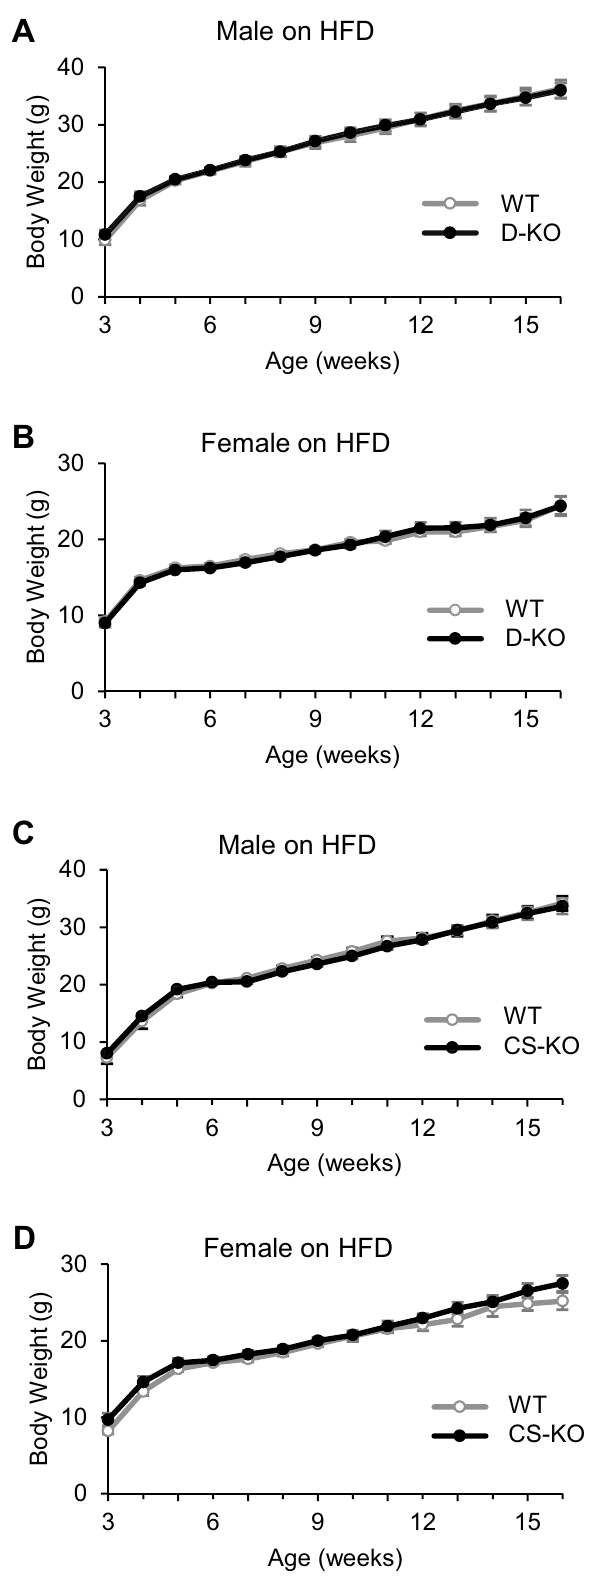
Figure 4. Glucocorticoid signaling in dopaminergic or corticostriatal neurons does not affect energy metabolism. ( A , B ) There was no significance between D-KO and WT mice for either male or female (n = 7–12 for each group). ( C , D ) There was no significance in body weight between CS-KO and WT mice for either male or female (n = 7–11 for each group). All values are mean ± SEM. Statistical analyses were performed using two- way ANOVA assessed for repeated